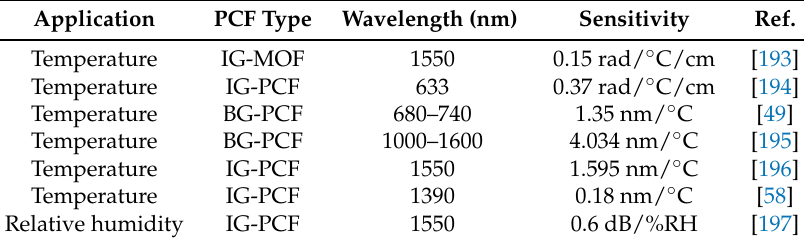
Table 4. Properties of most relevant solid-infiltrated PCF